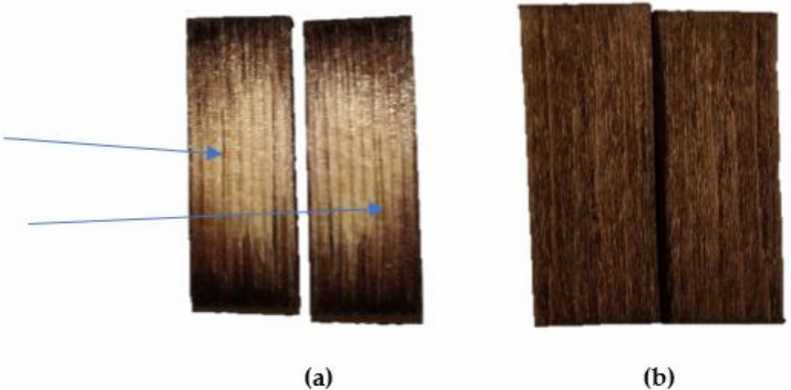
Figure 1. ( a ) Longitudinal section of spruce ( Picea abies ) sample impregnated with 10% of tannin water solution. ( b ) Longitudinal section of beech sample impregnated with 10% of tannin water solution. Wood cell pore sizes depend on species, radial position and environmental factors.